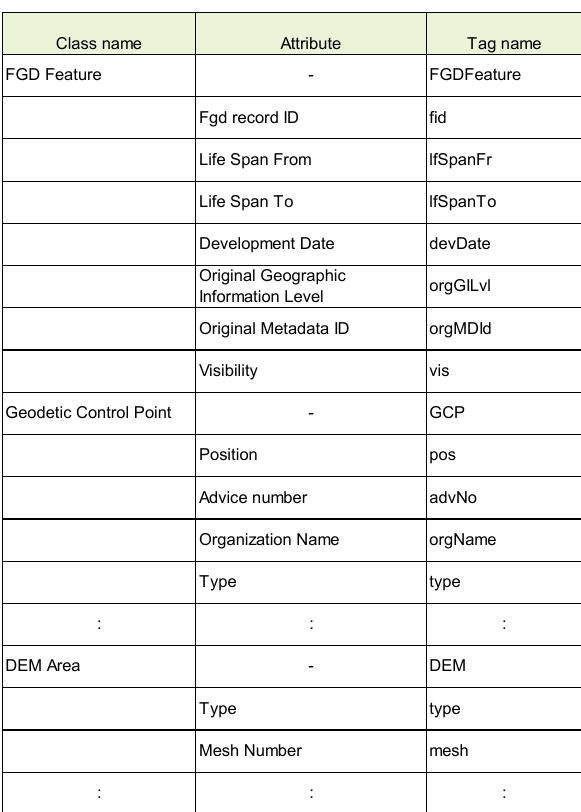
Table 1. Allocation of tag name (XML format)